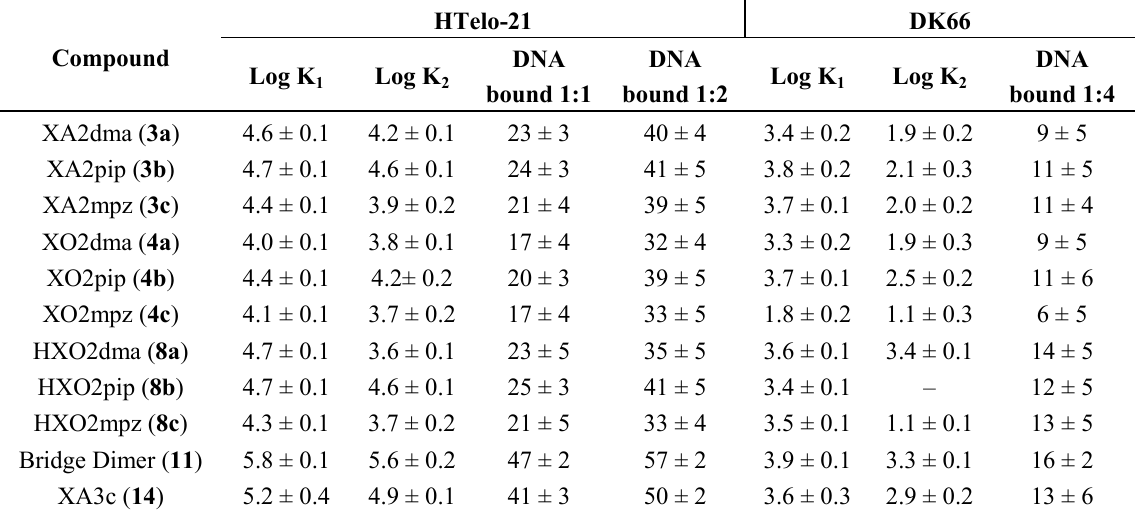
and K values calculated on a logarithmic scale and values of percentage of Table 2. K 1 2 bound DNA for experiments performed at 1:1 drug: DNA ratio for HTelo21 (or duplex DNA, DK66) and the indicated compounds with standard deviations reported over at least three independent